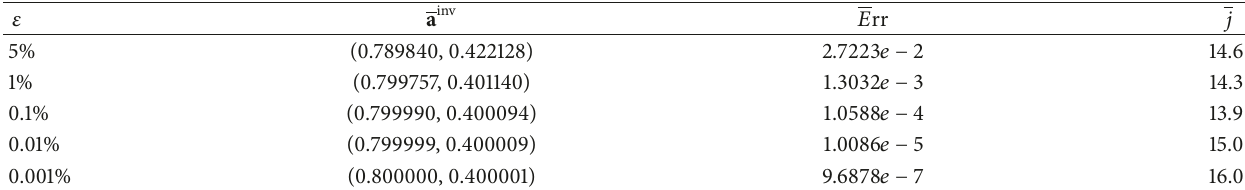
Table 3: The inversion results using noisy data for 𝑆 = 1